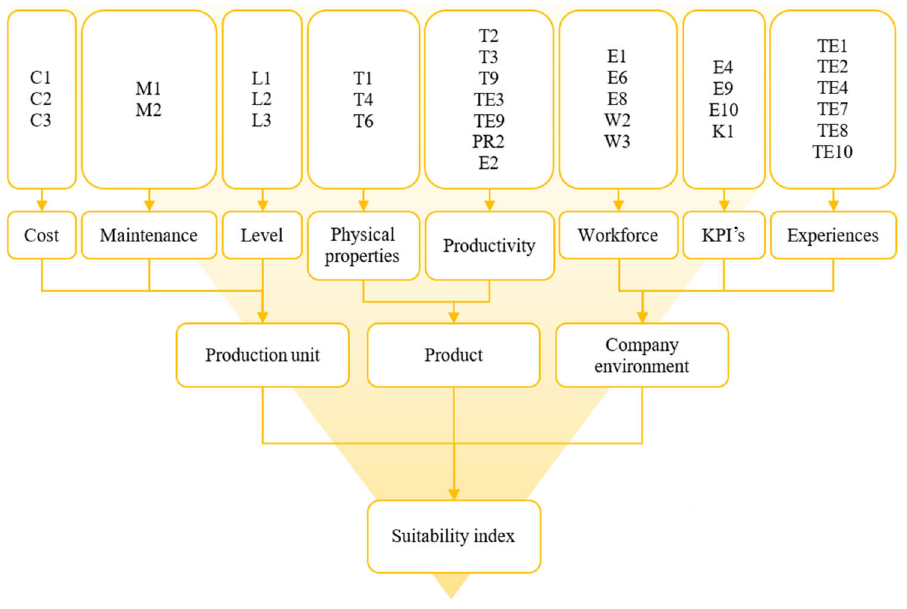
Fig. 2. Production cell suitability